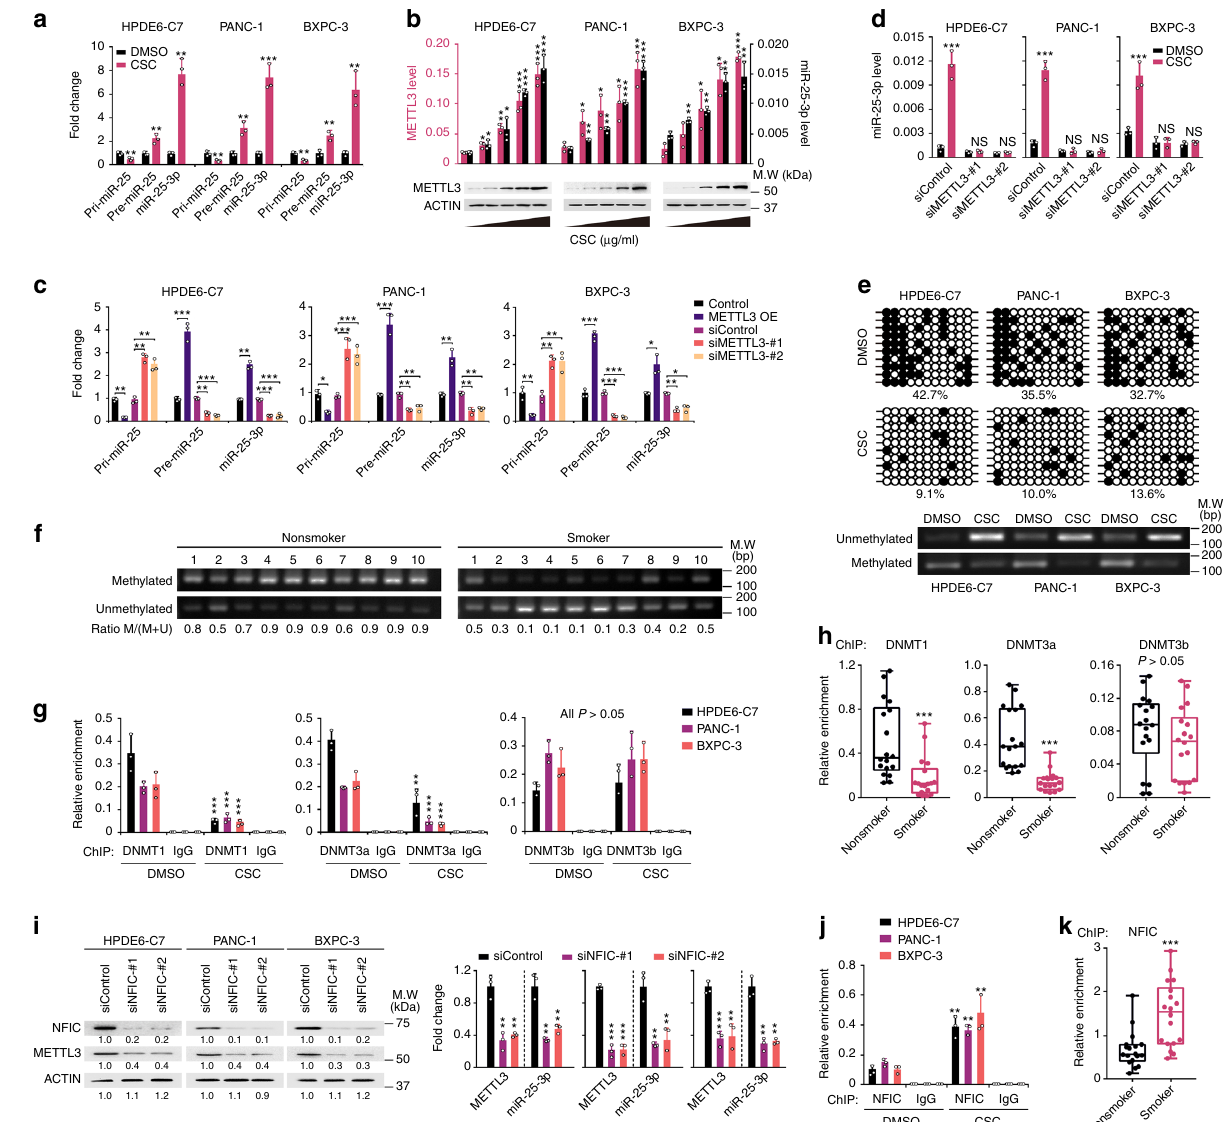
Fig. 2 CSC promotes pri-miR-25 maturation by upregulating METTL3 expression. a Relative expression levels of pri-miR-25, pre-miR-25, and miR-25-3p in HPDE6-C7, PANC-1, and BXPC-3 cells exposed to CSC (100 µ g/ml). b Effects of CSC on the expression of miR-25-3p and METTL3 mRNA (upper panel) and protein (lower panel) in HPDE6-C7, PANC-1, and BXPC-3 cells in a dose (0, 0.1, 1.0, 10, and 100 µ g/ml) dependent manner. c METTL3 overexpression or knockdown signi fi cantly affected the expression of pri-miR-25, pre-miR-25, and miR-25-3p in PDAC cells. OE, overexpression. d METTL3 knockdown signi fi cantly affected the expression of miR-25-3p in HPDE6-C7, PANC-1, and BXPC-3 cells exposed to CSC. e CSC (100 µ g/ml) induced hypomethylation of CpG island in the METTL3 promoter region (between – 284 and – 564 bp from transcription start site) detected by bisulfate sequencing (upper panel) and methylation-speci fi c PCR (lower panel) in HPDE6-C7 and PDAC cells. f Representative methylation-speci fi c PCR (MSP) of non-tumor tissues from smokers or nonsmokers showing the METTL3 CpG islands hypomethylation in smokers. Ratio (M/M + U) represents the methylated rate in indicated samples. g ChIP-qPCR assays showing decreased bindings of DNMT1 and DNMT3a but not DNMT3b within the METTL3 CpG islands caused by CSC. h Quantitative ChIP analysis of DNMT1, DNMT3a, and DNMT3b levels within the METTL3 regulatory region in non-tumor tissues from 36 patients (18 smokers and 18 nonsmokers). i NFIC knockdown signi fi cantly affected the expression levels of METTL3 proteins (left panel) and RNA and miR-25-3p (right panel). Results of RNA represent means± S.D. from three independent experiments. j ChIP-qPCR assays showing signi fi cantly increased direct binding of NFIC to METTL3 promoter in HPDE6-C7 and PDAC cells exposed to CSC. k Quantitative ChIP analysis showing signi fi cant difference in the NFIC levels within the METTL3 regulatory region between smokers ’ and nonsmokers ’ non-tumor pancreatic tissues (both N = 18). Data of ( h ) and ( k ) are displayed in min to max boxplot. The line in the middle of the box is plotted at the median while the upper and lower hinges indicated 25th and 75th percentiles. Values are the mean ± S.D. from three independent experiments, and all statistic analyses in this fi gure are Student t test. * P < 0.05, ** P < 0.01, *** P < 0.001 and NS, not signi fi cant as compared with the corresponding control